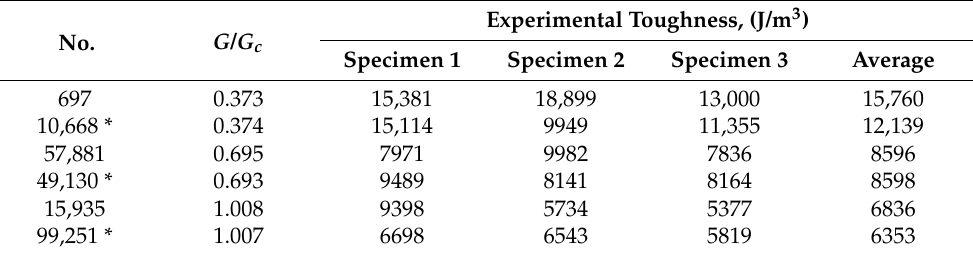
Table 3. Comparison of simulated fracture criterion G / G c and experimental toughness of 6 design patterns (* soft material ahead of the crack